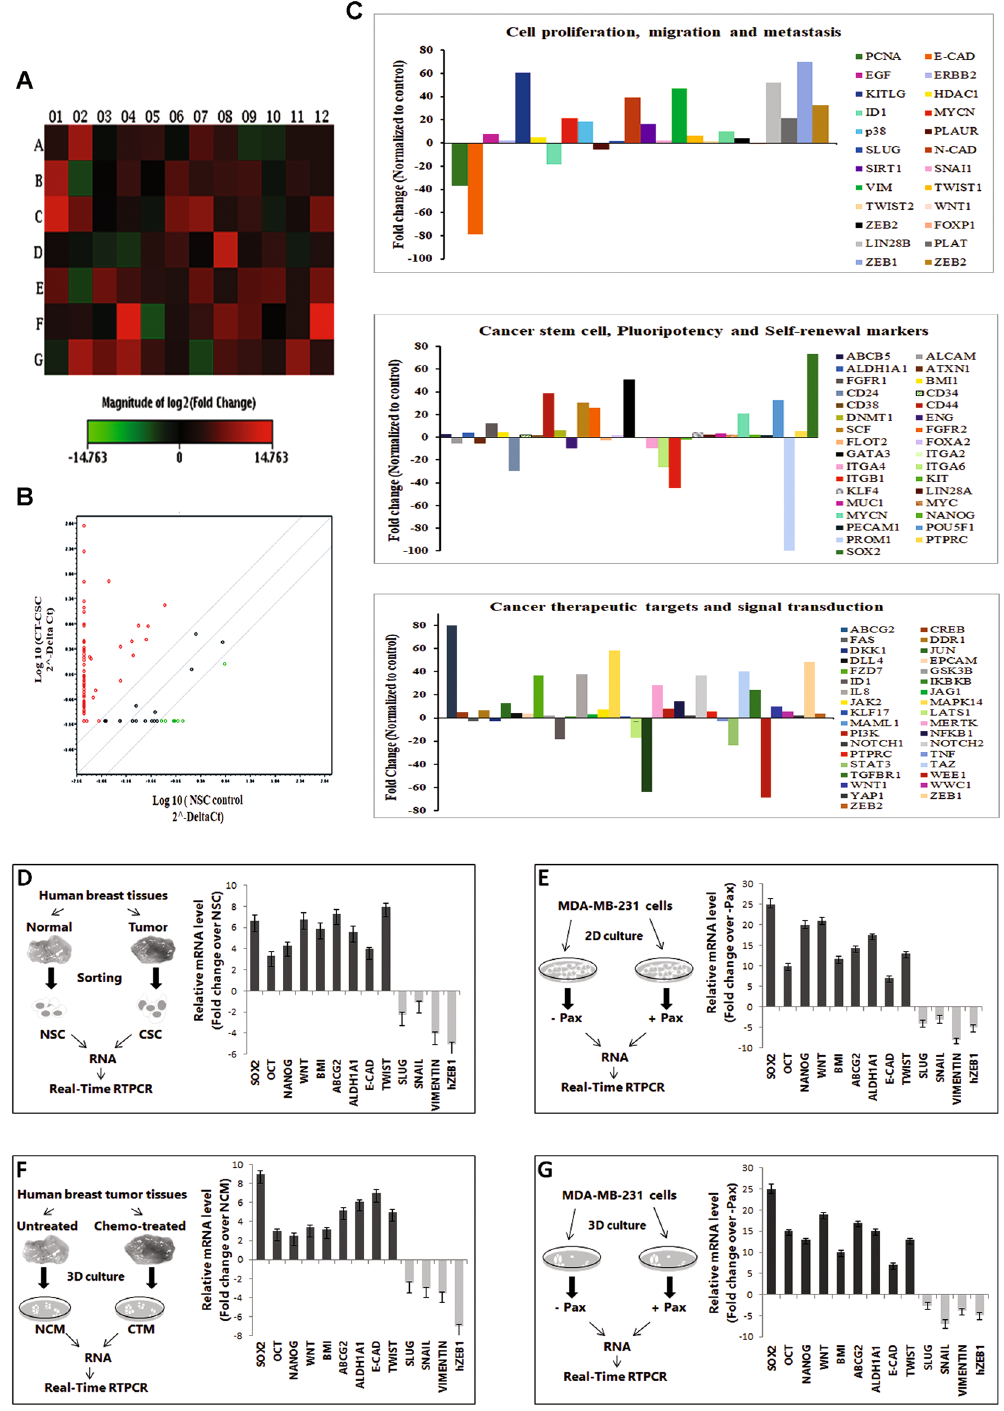
Figure 3. Microarray analysis elucidates differentially expressed stem cell-related genes in normal breast stem cells (NSC) and breast cancer stem cells from chemo-treated TNBC patients (CT-CSC). ( A ) Heat Map of the 96 genes in the RT 2 profiler array plate for Cancer Stem Cells showing the fold regulation (log2 fold change) of various genes from the chemo-treated CSCs of TNBC tumors normalized to normal stem cells (NSCs) from the same patient. ( B ) A scatter plot showing the normalized expression of all genes on the array between CT-CSC and NSC to visualize large gene expression changes. The central line indicates unchanged gene expression. ( C ) Multigroup plots to represent the expression of selected genes from the array with grouping under three different functional categories. ( D ) qRT-PCR analysis for stemness, chemoresistance and EMT genes from ALDH + population of normal (NSC) and chemo-treated TNBC tumor (CSC). ( E ) Expression of genes from Pax-treated ( + PAX, 2 nM) MDA-MB-231 compared to control cells ( − Pax). ( F ) Expression of genes in spheroids cultured from chemo-treated TNBC tumor (CTM) compared to spheroids from